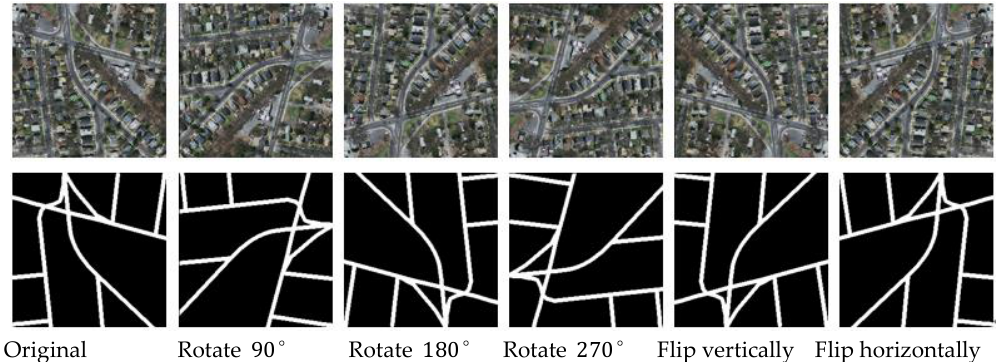
Figure 5. Data augmentation. The method mainly includes rotation, flipping (horizontally and vertically), and cropping operations.